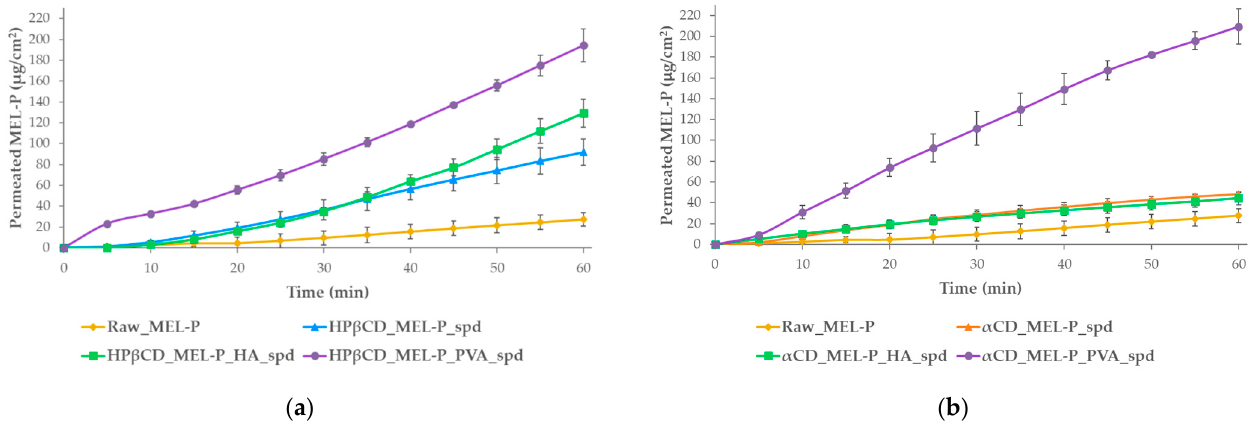
Figure 7. In vitro permeability study of raw MEL-P and: ( a ) the HP β CD-containing and ( b ) the α CD-containing spray dried samples . Table 3. Enhancement ratios .